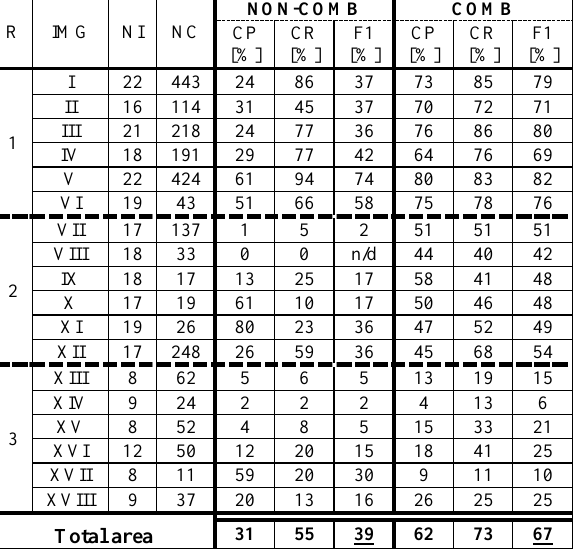
Table 2: Evaluation results for the investigations based on a non-varying and varying degree of